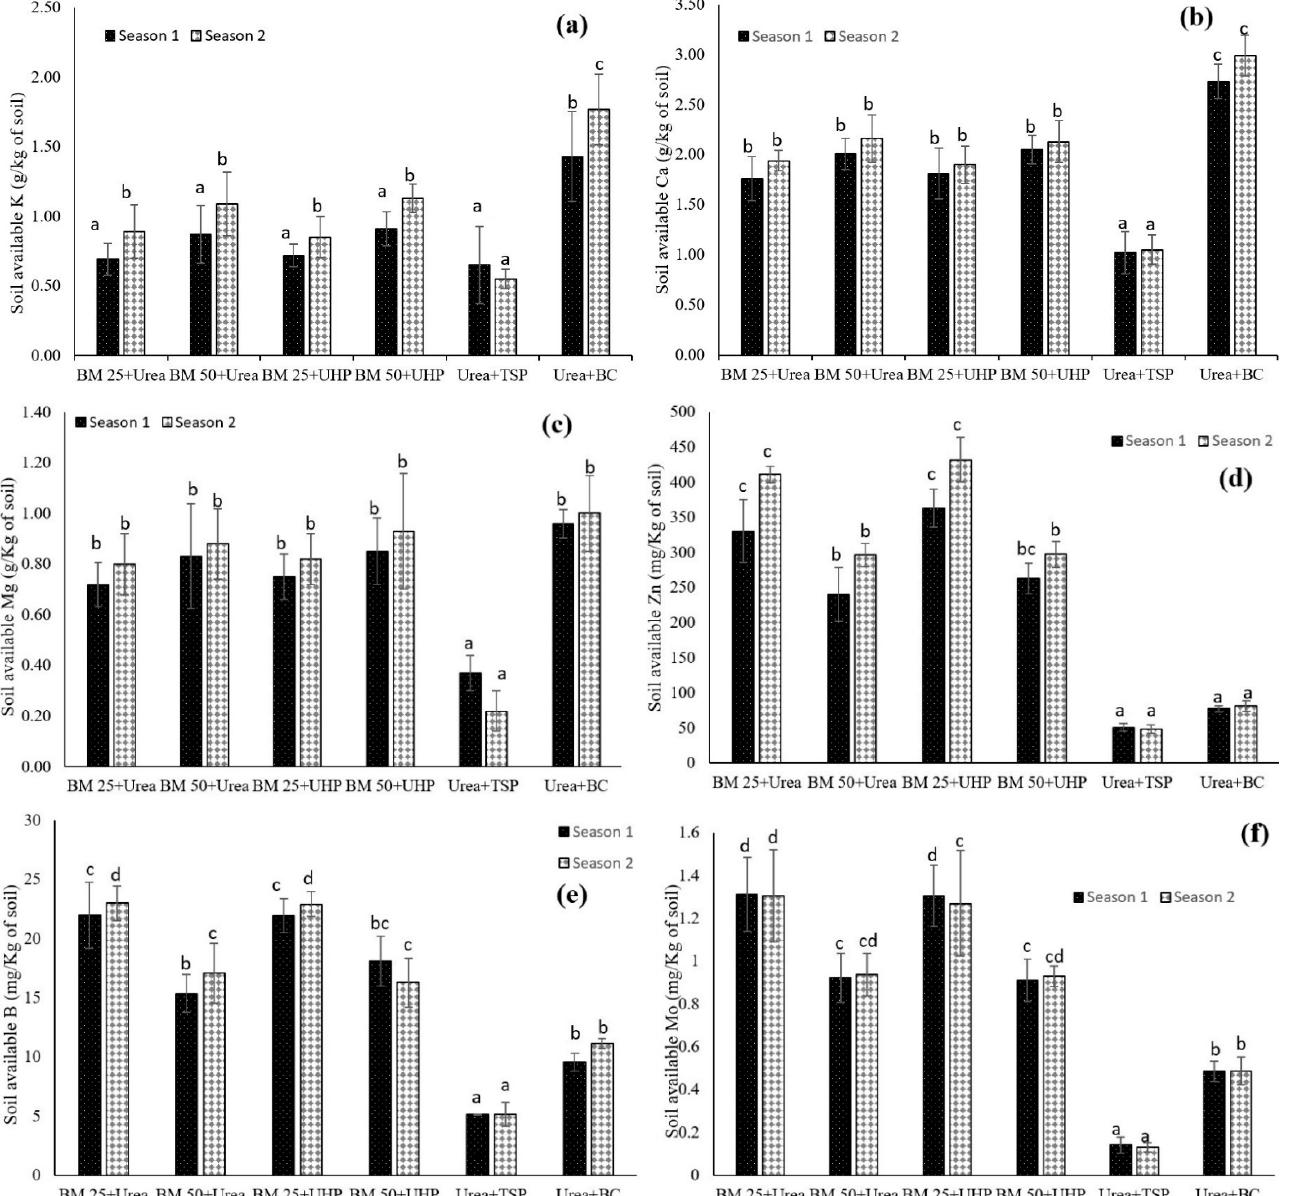
Figure 4. The quantities of soil-available ( a ) K, ( b ) Ca, ( c ) Mg, ( d ) Zn, ( e ) B, and ( f ) Mo obtained from the different amendments at the end of each lettuce growing season.